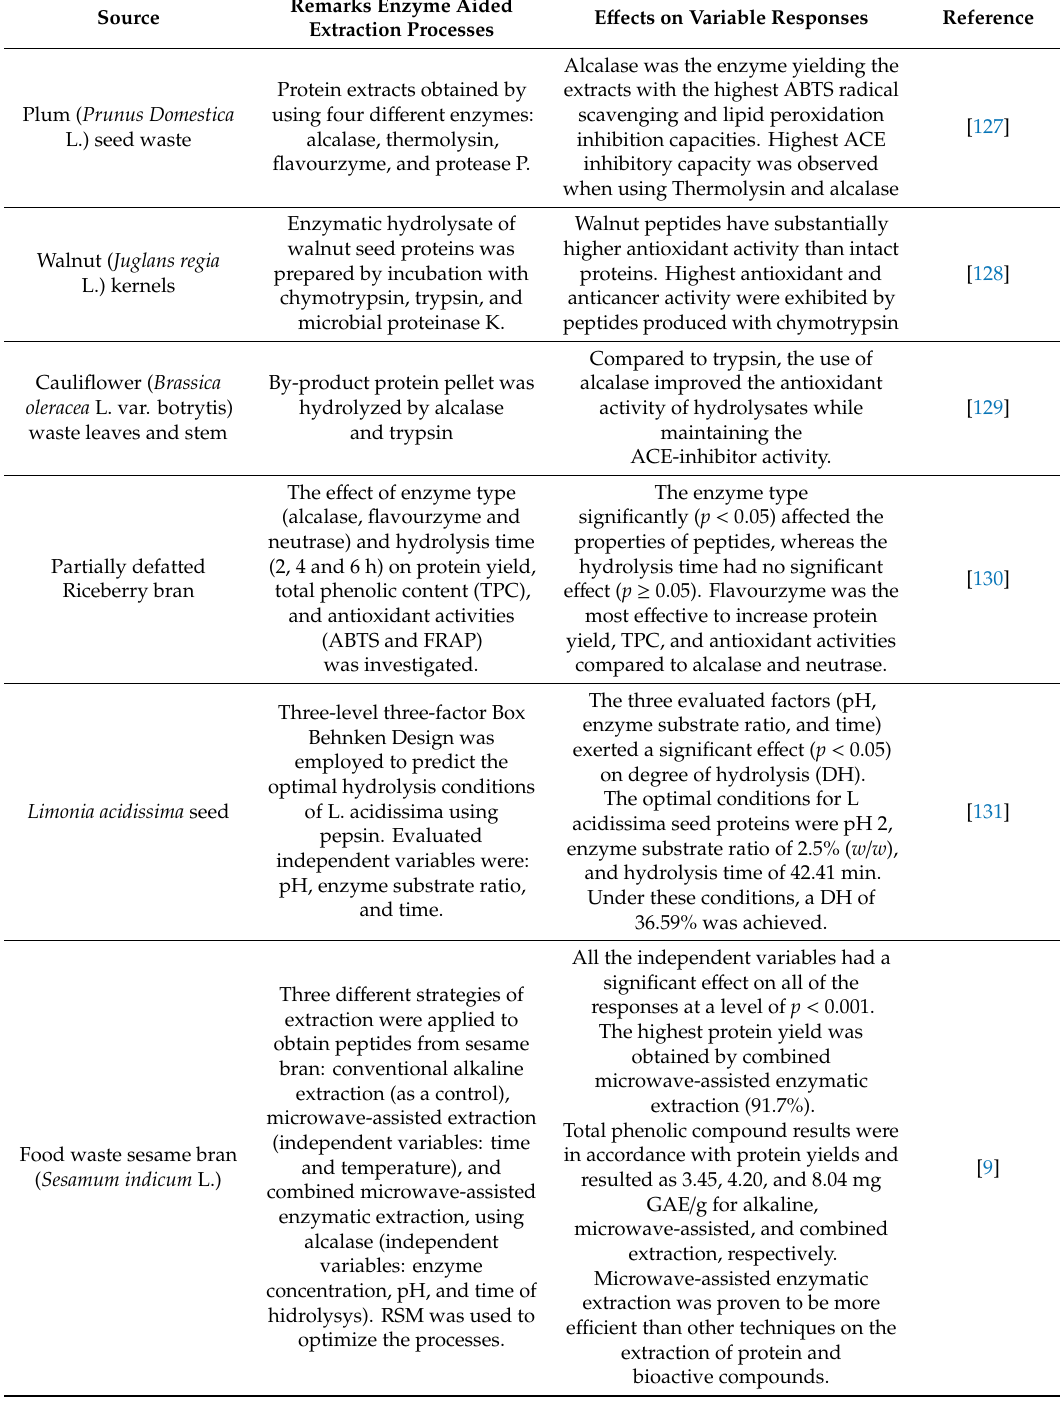
Table 2. Applications of enzyme assisted extraction for the production of bioactive peptides from vegetable